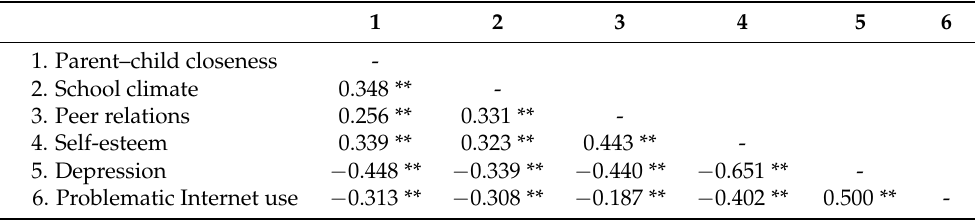
Table 2. Pearson correlations among the key variables.